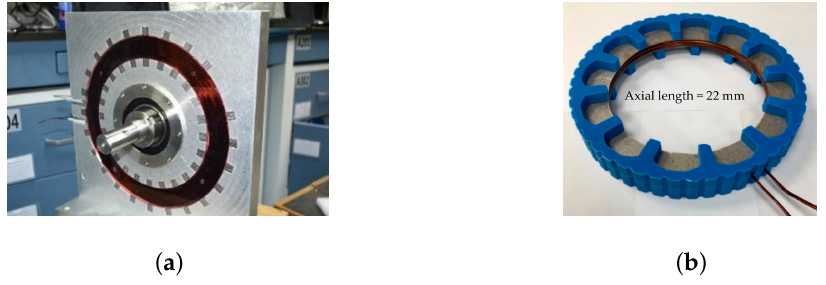
Figure 19. Prototypes of ( a ) a TF wind generator [66], ( b ) the 3D printed stator of a TFM [98].